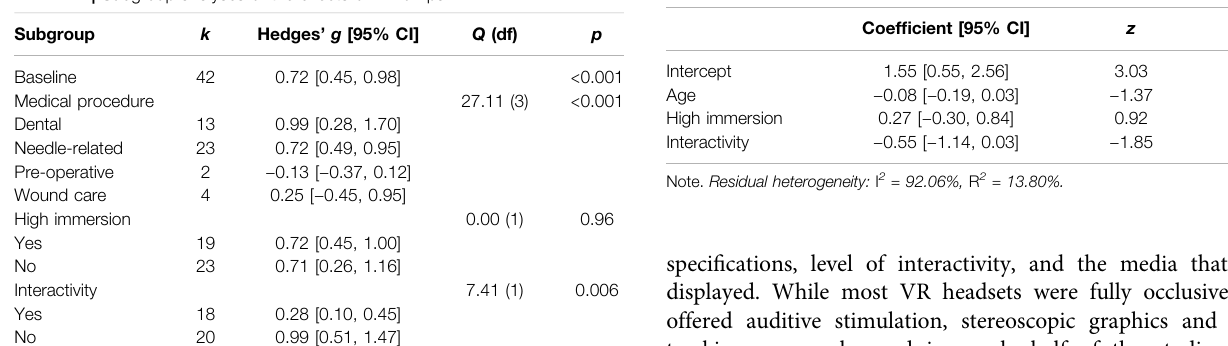
TABLE 4 | Subgroup analyses of the effects of VR on pain. TABLE 5 | Results of meta-regression analysis on the effects of VR on